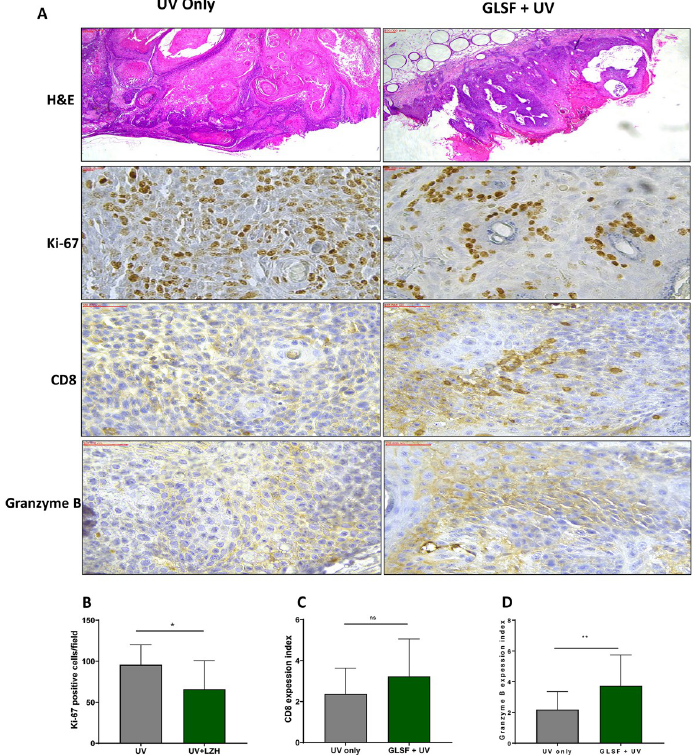
Fig 4. Effects of GLSF and UV on histology and expression of Ki-67, CD8 and Granzyme B in skin tumor in SKH- 1 mice. (A) Histology of tumor tissues showing SCC and papilloma in control and GLSF treatment groups (H&E staining, 4x) and IHC analysis of Ki-67 (40X), CD8 (40X) and Granzyme B (40X) treated with UV with or without GLSF. (B) Quantification of the number of Ki-67 positive cells, which were counted in three randomly selected fields and averaged to obtain a single skin sample data (n = 5). (C) The expression index was used to quantify the extent and intensity of CD8 and (D) Granzyme B expression in tumor samples obtained from control or GLSF groups (n = 5). An unpaired t test was used to assess statistical differences. � : P < 0.05, �� : P < 0.01. ns: not significant.